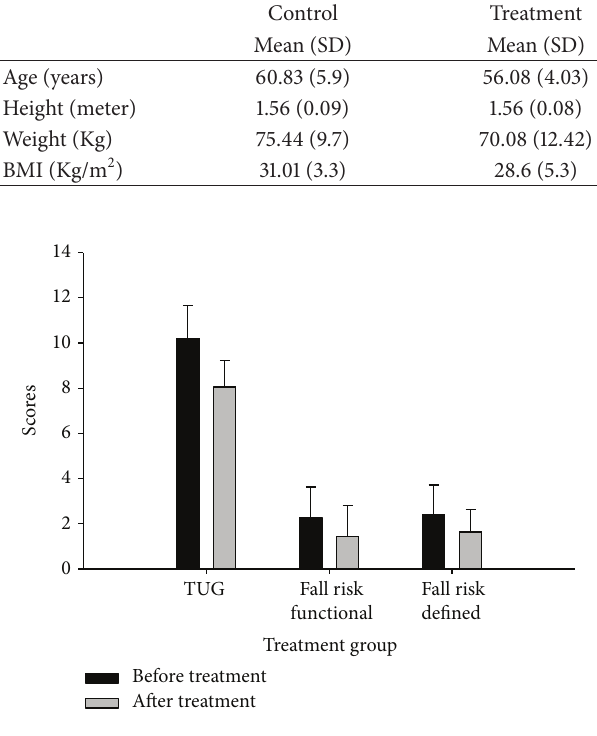
Figure 1: TUG test (in seconds) and fall risk scores before and after